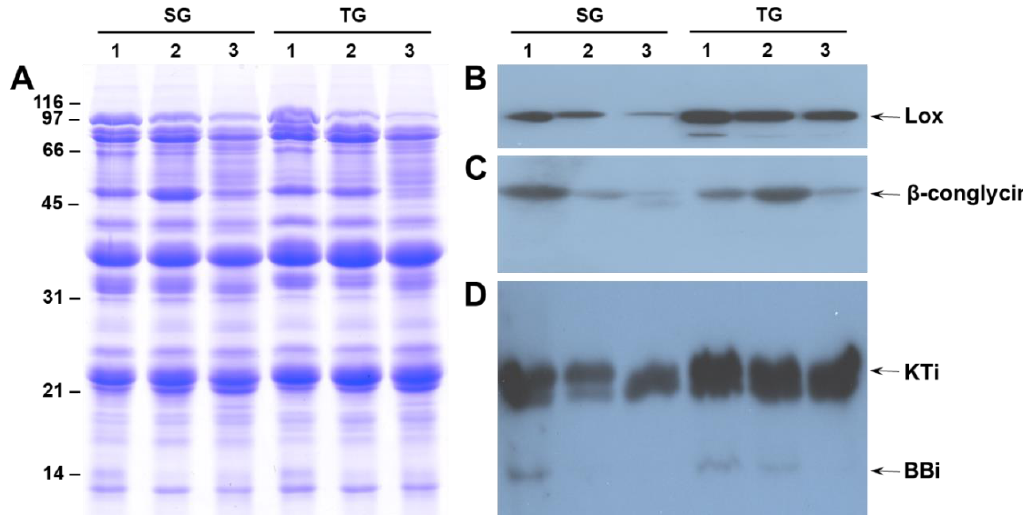
Figure 1. One-dimensional sodium dodecyl sulfate–polyacrylamide gel electrophoresis (SDS-PAGE) analysis of soybean total seed proteins (Panel A ). Total seed proteins extracted from heat stress sensitive soybean genotype DT97-4290 (SG) and heat stress tolerant soybean genotype DS25-1 (TG) genotypes grown at 28/22 °C (lane 1) or 36/24 °C (lane 2) and 42/26 °C (lane 3) day/night temperatures were analyzed by 13.5% SDS-PAGE. Resolved proteins were detected by staining the gel with Coomassie Blue (Panel A ) or transferred to nitrocellulose membrane and probed with antibodies raised against lipoxygenase1 (Panel B ), the β-subunit of β-conglycinin (Panel C ) and Bowman-Birk inhibitor (Panel D ). The molecular weight markers whose sizes in kilodaltons are shown on the left side of the figure. The identity and approximate position of major seed storage proteins is indicated by arrows.